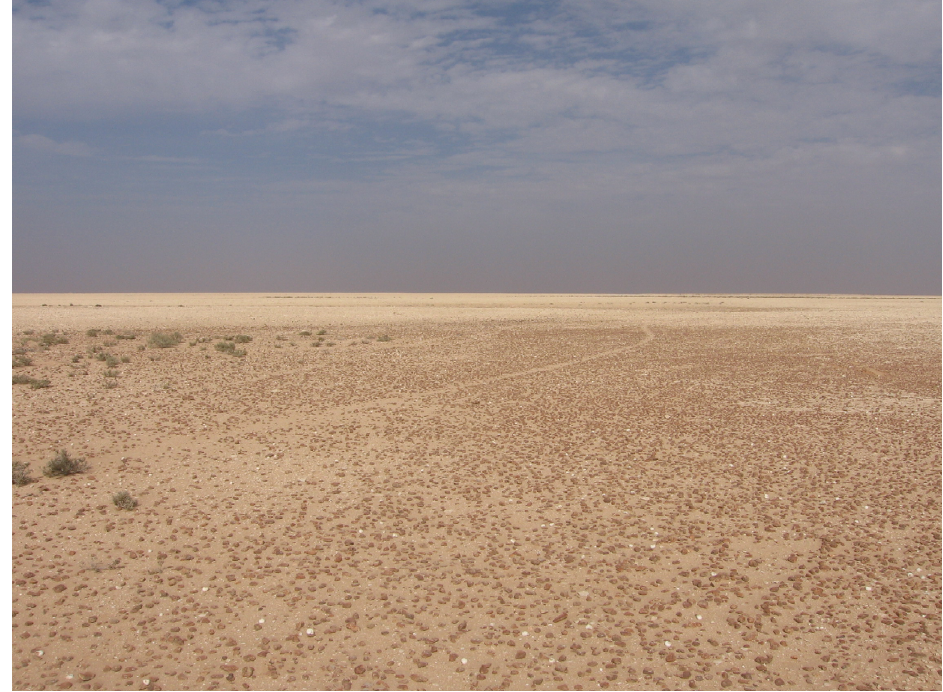
Fig. 11. Traces of tracks on the stony surface at Bir Qatrani (cf. Fig. 4). (Olaf